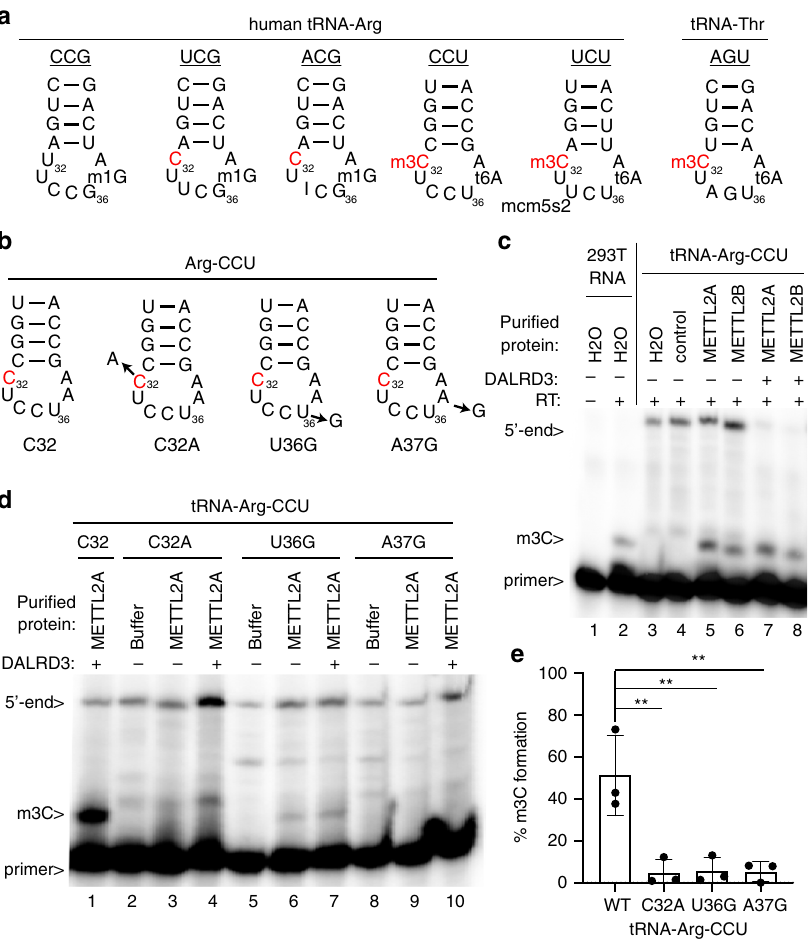
recognition and interaction of speci fi c arginine tRNAs with METTL2A/B. To investigate the requirement for DALRD3 in m3C formation in vivo, we engineered human cell lines lacking DALRD3 using CRISPR/Cas9 gene editing. Using the HAP1 human haploid cell line 42 , we generated a cell clone containing a 14 base-pair deletion in exon 1 of the DALRD3 gene (Supple- mentary Fig. 4a). The deletion is predicted to produce a truncated DALRD3 missing the majority of the polypeptide or a translation frameshift that results in nonsense mediated decay (NMD).